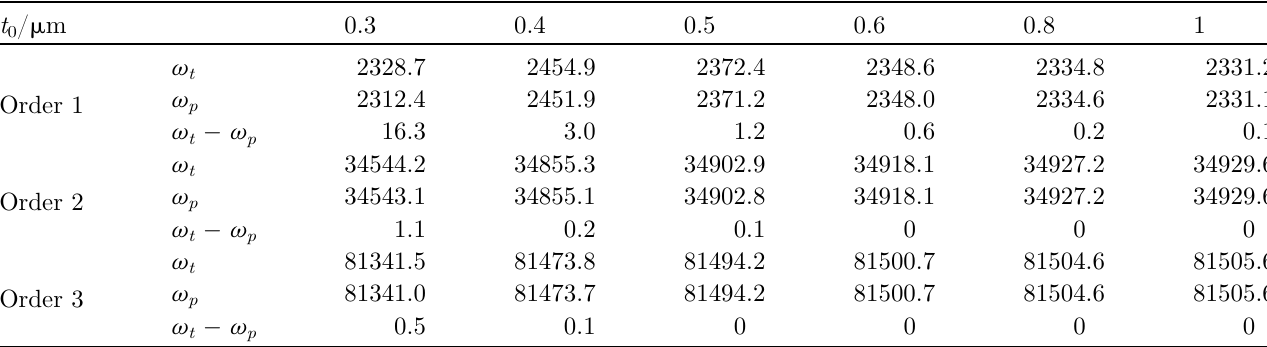
with and without damping (rad/s). 0